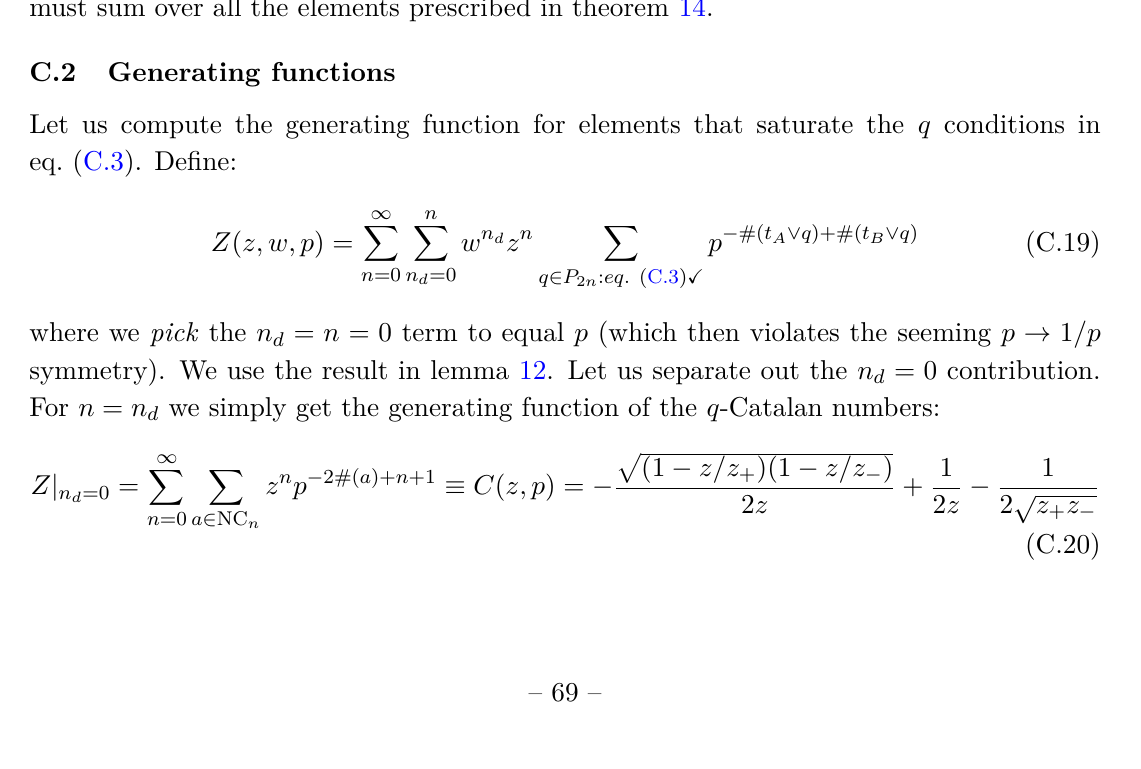
is shown in blue. The purple B